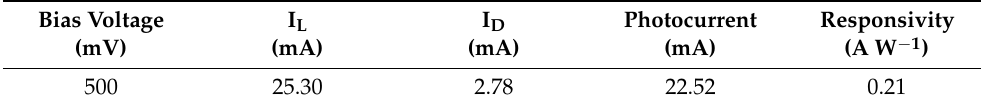
Figure 7. SEM images of ( a ) surface and ( b ) cross-sectional view of 570 nm thick CuCrS 2 thin film fabricated on Mo-coated glass substrate. ( c ) Current-voltage (I-V) characteristics of CuCrS 2 thin film structure under white light illumination at 100 mW cm − 2 with an inset showing a schematic of the fabricated structure for I-V measurements. Table 1. Photocurrent and responsivity of CuCrS 2 thin film electrode. Bias